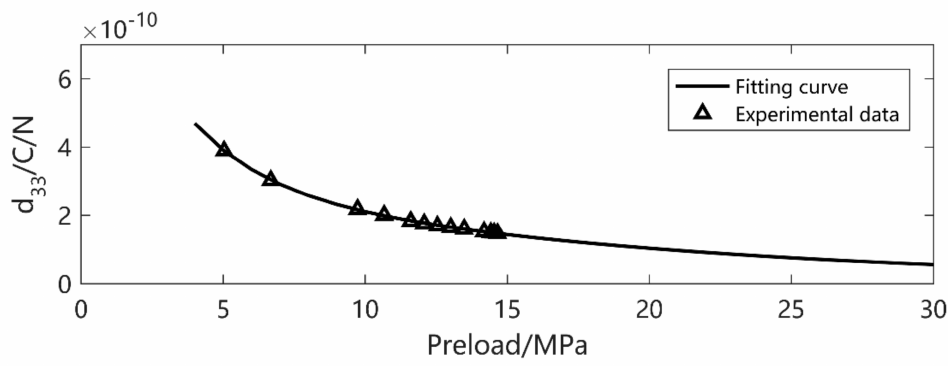
Figure 3. d 33 value versus